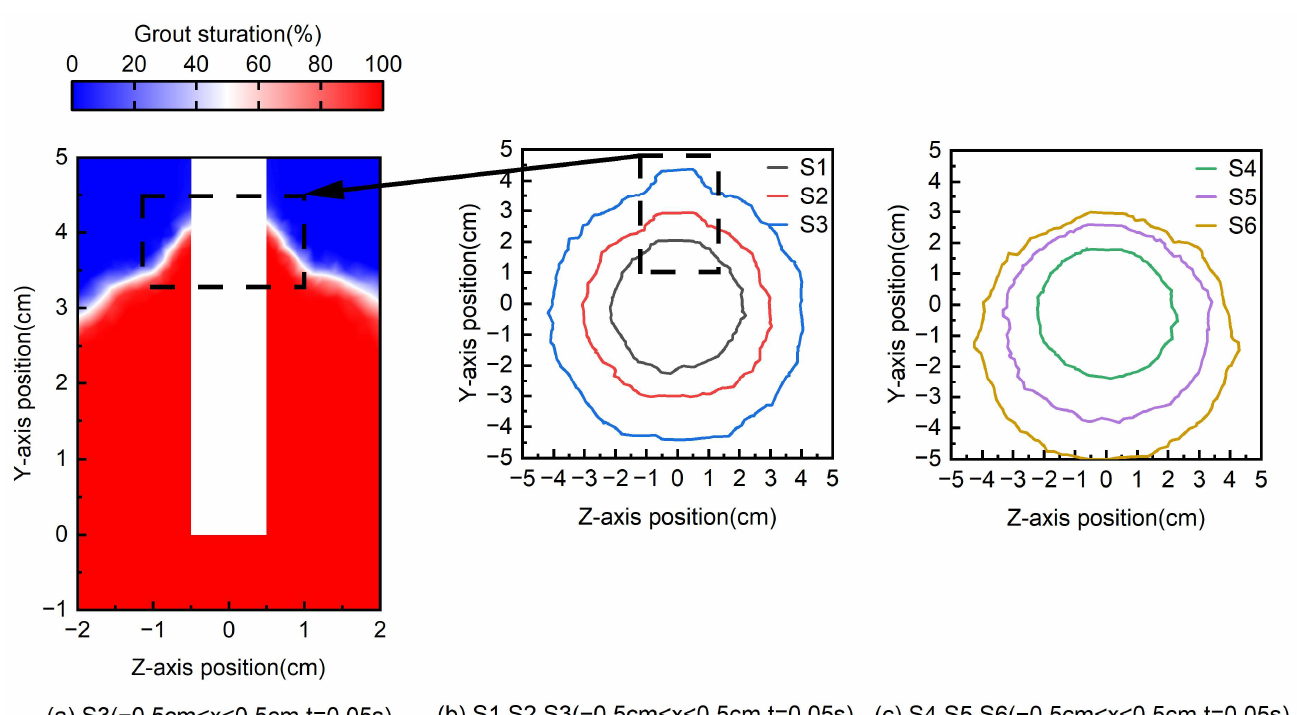
Figure 10. Slurry diffusion boundary (t = 0.05